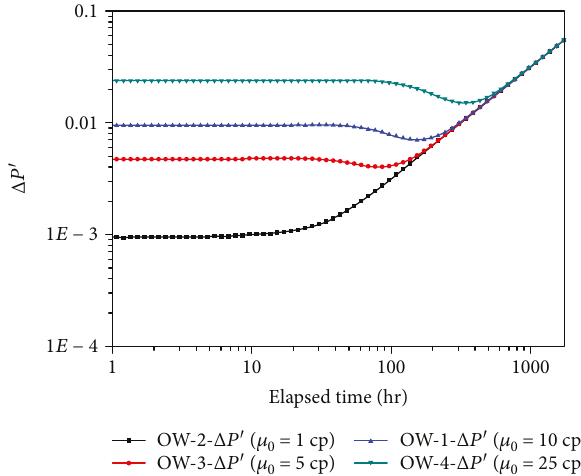
Figure 14: The log-log plot of pressure response in a reservoir under di ff erent oil viscosities. If oil viscosity is greater, without P c the time that takes to reach the transition zone is